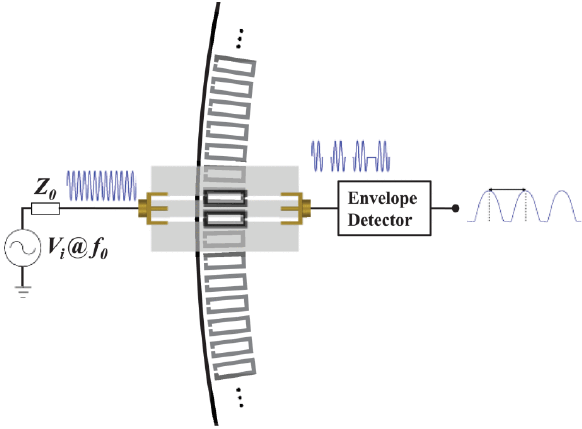
Figure 17. Sketch of the rotation sensor based on the edge configuration. From [29], reprinted with permission.